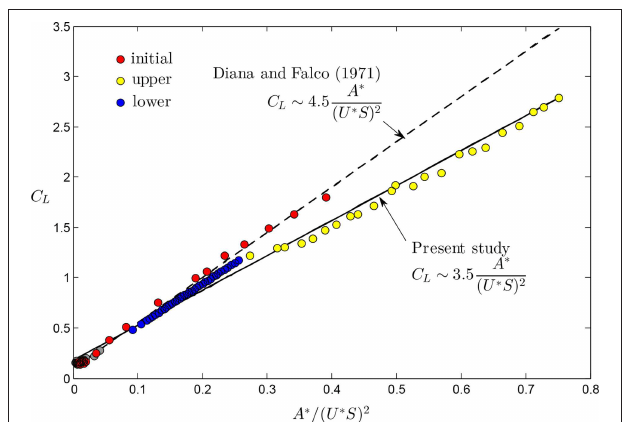
FIGURE 13 | Variation of the mean, effective, and apparent drag coefficients with reduced